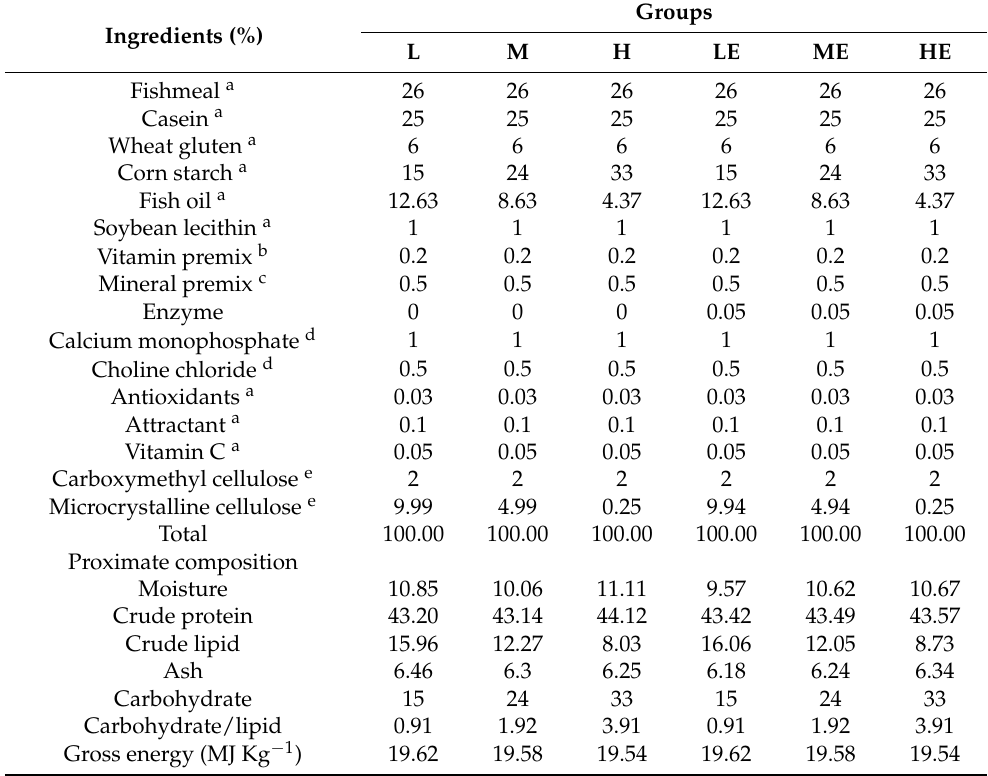
Table 1. Formulation and proximate analysis of trial diets (dry matter, DM